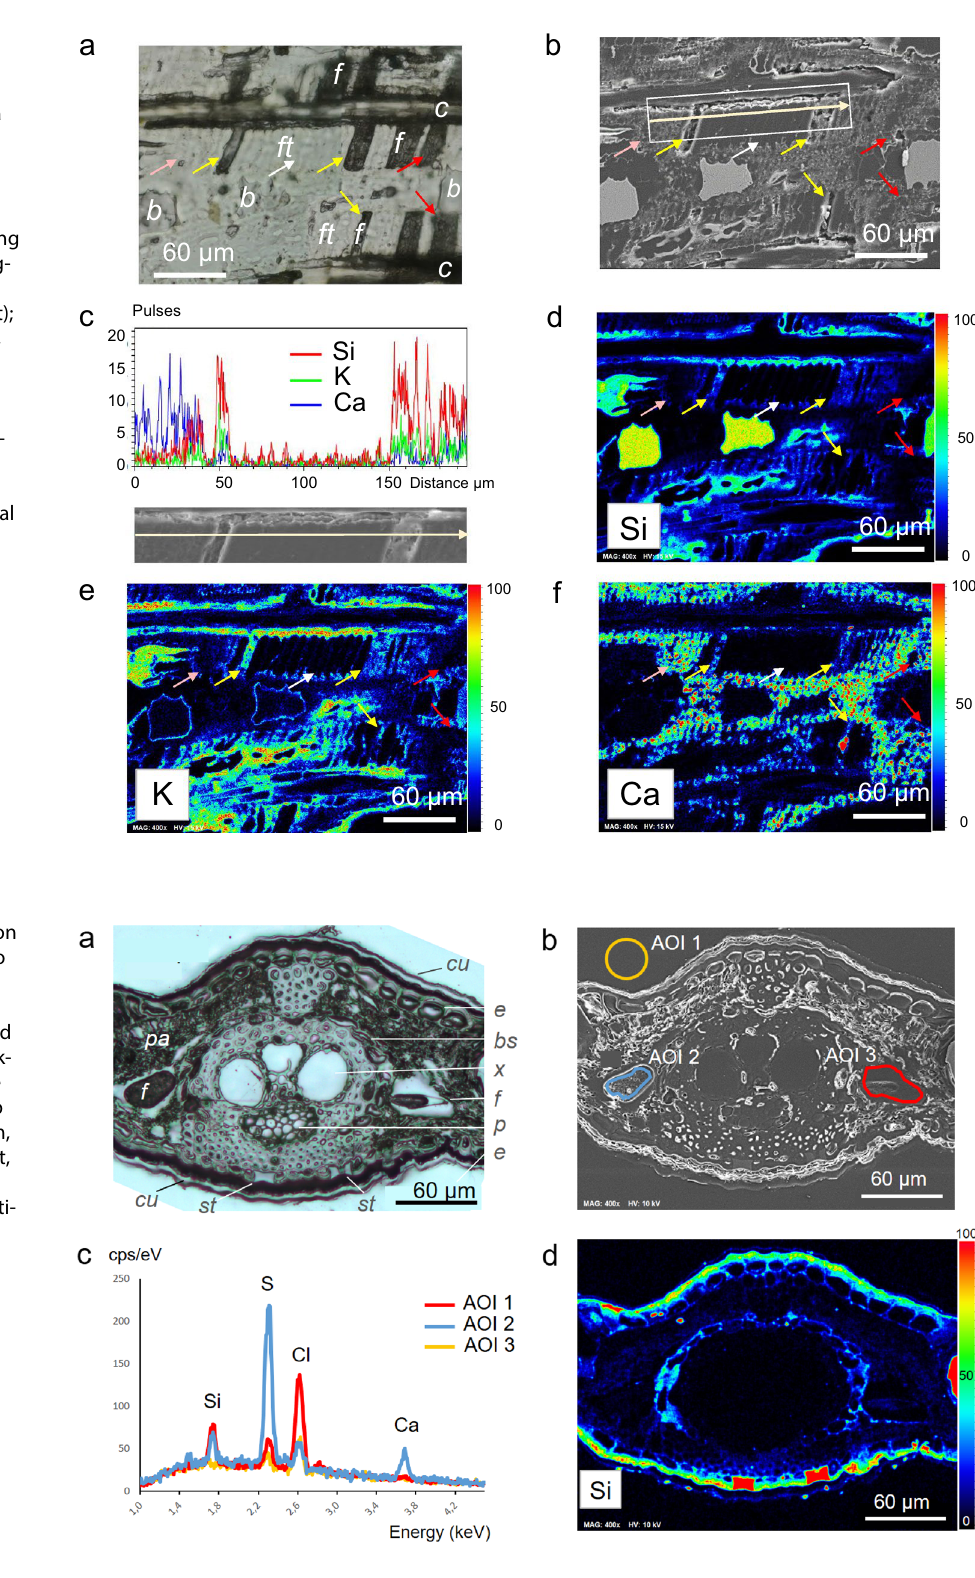
Fig. 6 Fusoid cells attached to costal zones with three bulliform cells in the inter- costal zone (San Carlos-10). a Light microscope picture; b SEM image with demarcated location of the EDS transect across a row of fusoid cells; c